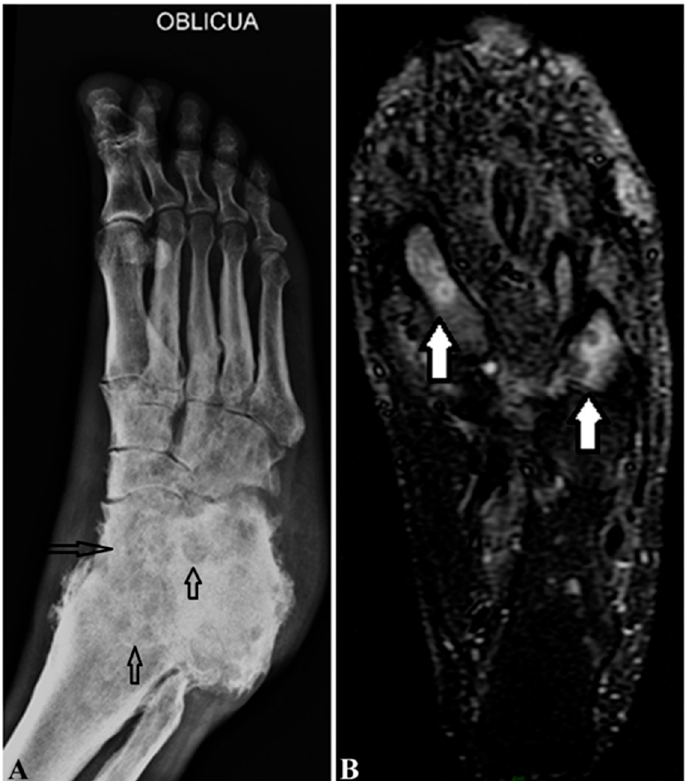
Figure 4. Radiographs of actinomycetoma on a foot. ( A ) Oblique radiograph of actinomycetoma on the right foot revealing multiple, mixed punched-out (lytic and blastic) cavities (black hollow arrows) of the tarsus and obliteration of joint margins. ( B ) Coronal MRI view in STIR sequence of the left foot of a 40-year-old male with actinomycetoma showing at least two lesions in the first and fourth metatarsal bones with “dot in circle” signs (white solid arrows) characterized by a hyperintense circle in T2-weighted sequences with a hypointense center. Courtesy of Dr. Jesus Dante Guerra.